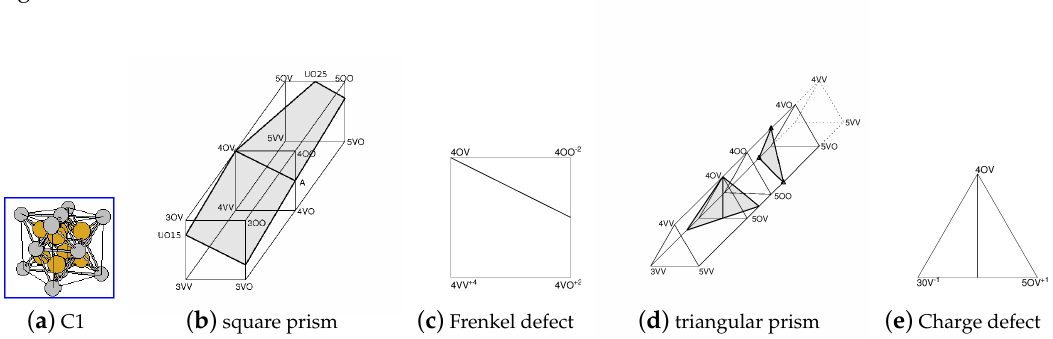
Figure 8. Graphical interpretation of the relations between endmembers and defects in UO 2 in Equations (32) and (33). The two prisms in ( b ) and ( d ) contain all 12 endmembers in slightly different arrangements. In ( c ) the endmembers related to the Frenkel defect are shown and in ( e ) are those related to the charge